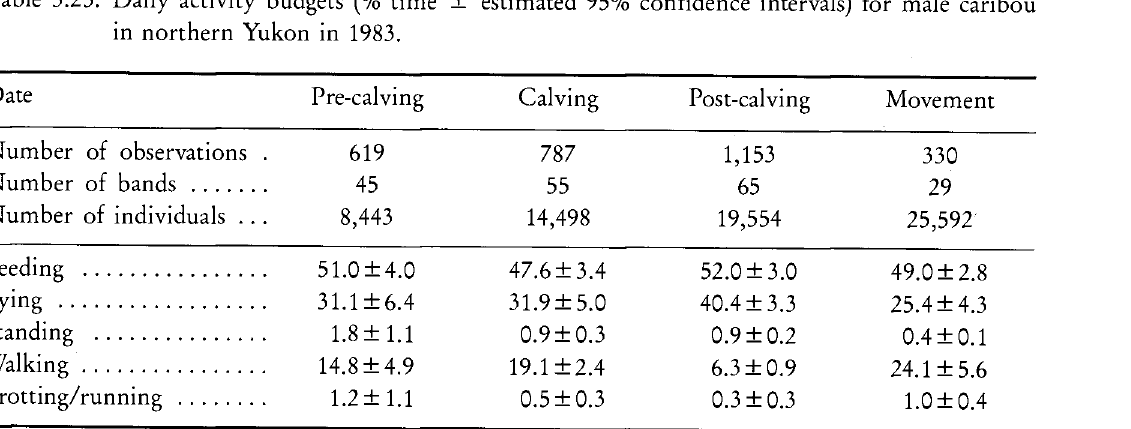
Table 3.25. Daily activity budgets (% time ± estimated 95% confidence intervals) for male caribou in northern Yukon in 1983.